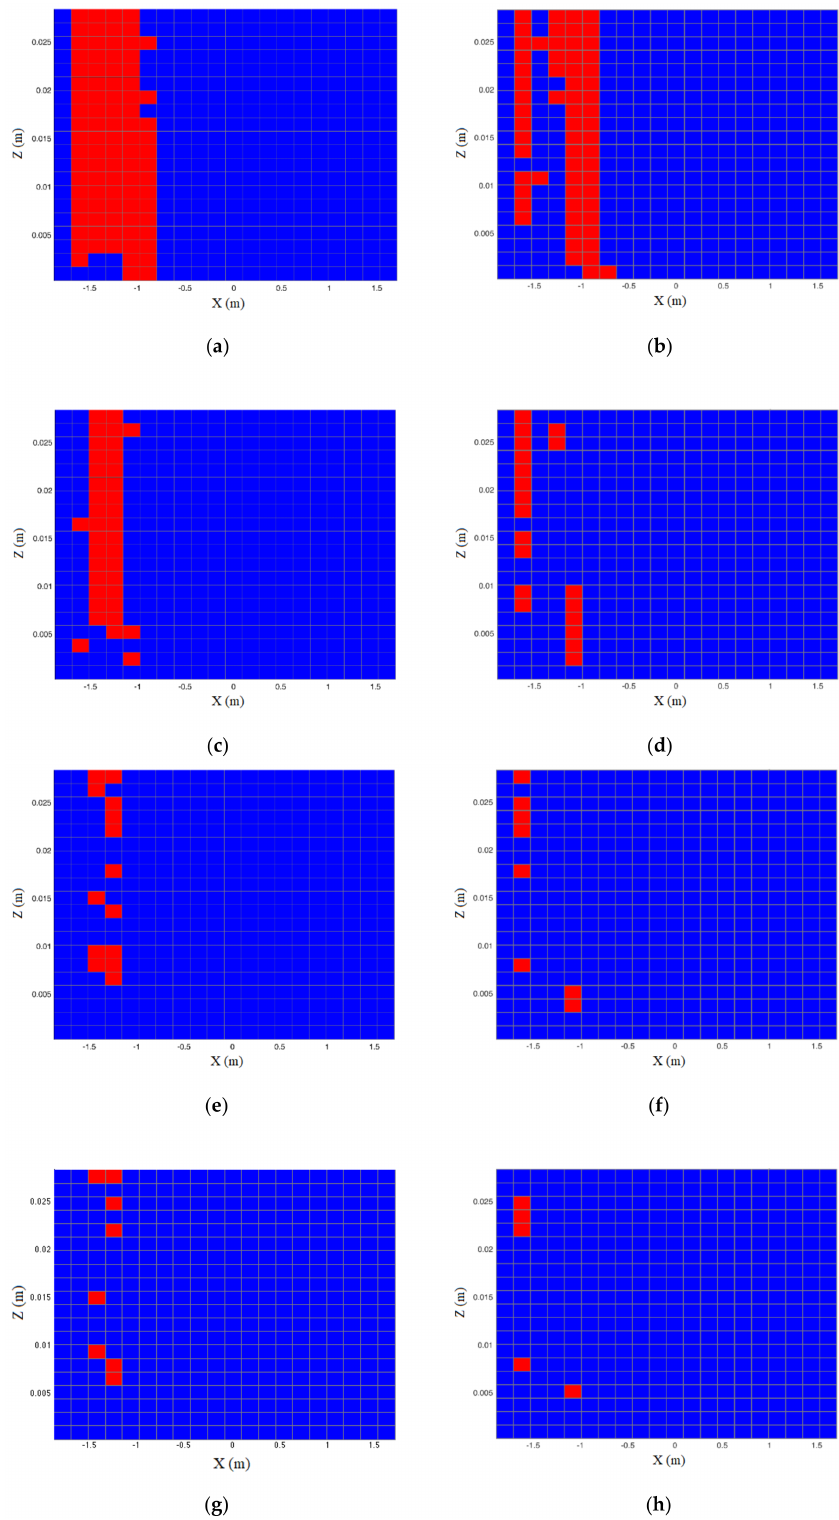
Figure 16. Probable source regions with different threshold values in explicit and implicit methods: ( a ) threshold value is 1 in explicit method; ( b ) threshold value is 1 in implicit method; ( c ) threshold value is 0.6 in explicit method; ( d ) threshold value is 0.6 in implicit method; ( e ) threshold value is 0.2 in explicit method; ( f ) threshold value is 0.2 in implicit method; ( g ) threshold value is 0.1 in explicit method; ( h ) threshold value is 0.1 in implicit